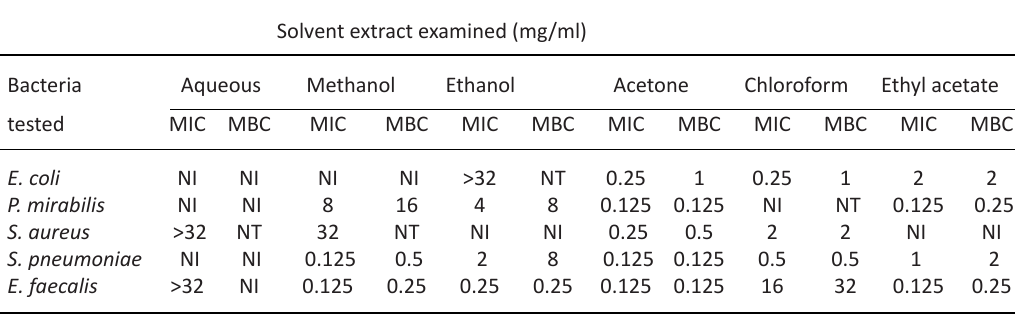
Table 3. Minimum Inhibitory and Minimum Bactericidal Concentration (MIC and MFC) of Laurus nobius extracts Solvent extract examined (mg/ml)